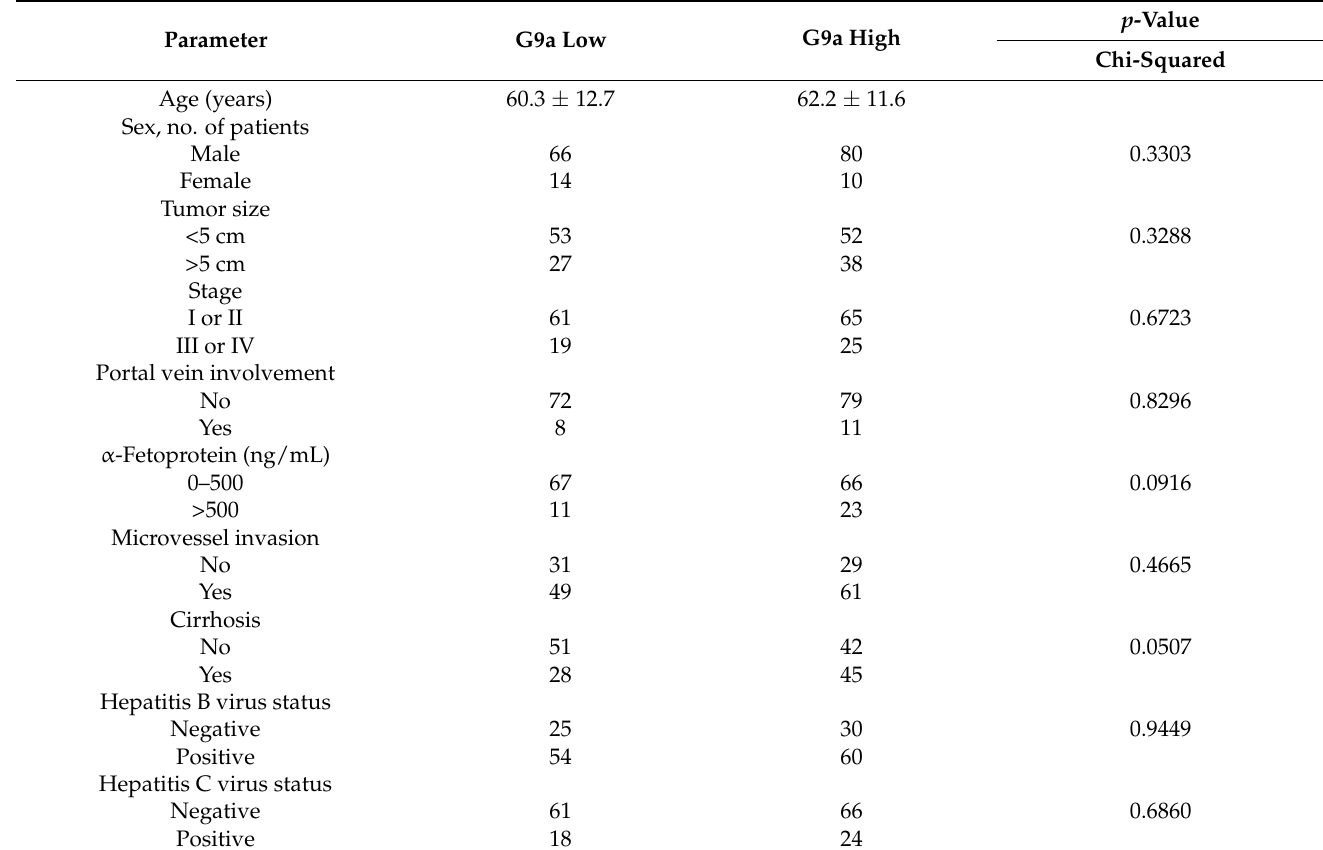
Table 1. Clinicopathologic characteristics of hepatocellular carcinoma patients with low and high expression of G9a.